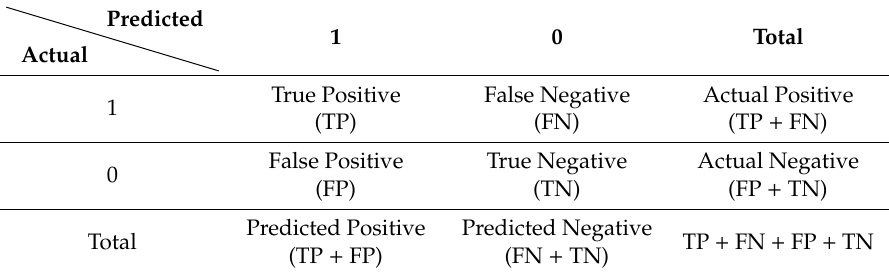
Table 4. Confusion